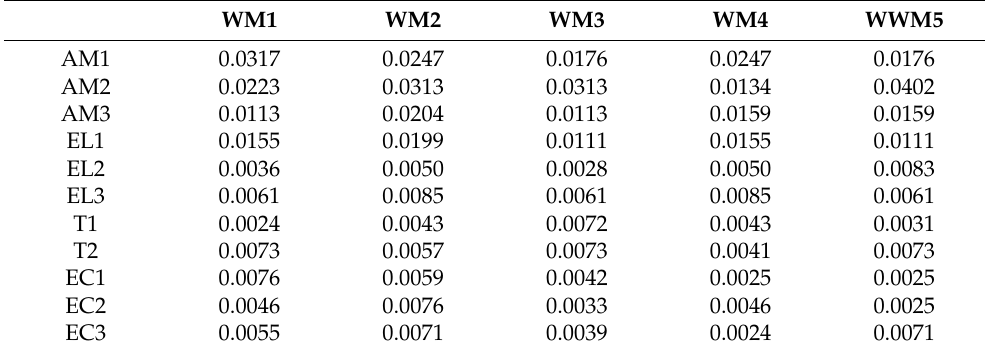
Table 5. Weighted Aggregated Sum Product Assessment judgement matrix, weighed and normalized for summary parts.